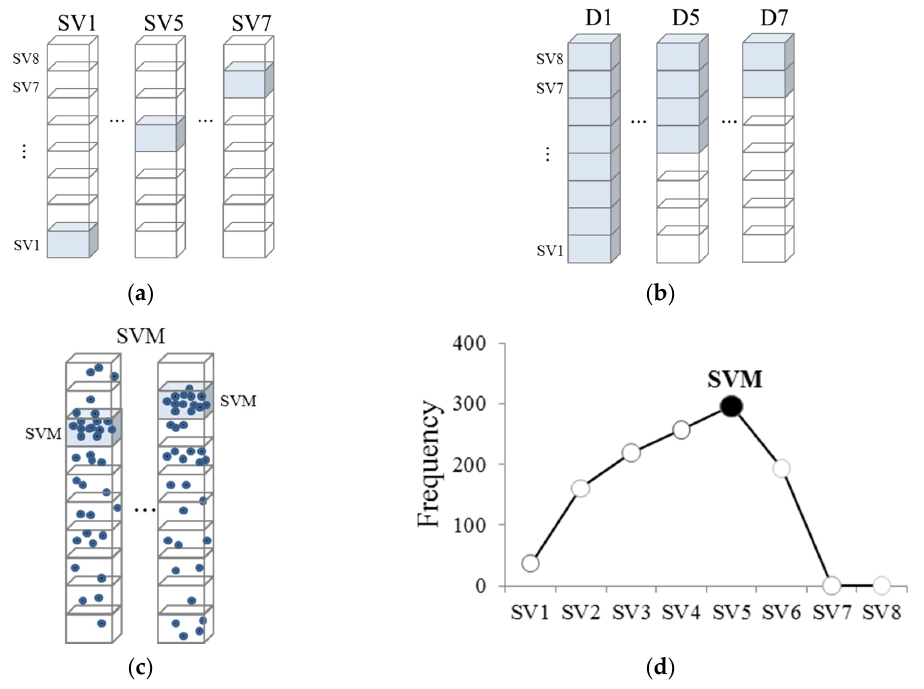
Figure 4. Illustration of the concepts of ( a ) Variable SVi; ( b ) Variable Di; ( c ) Variable SVM; and ( d ) finding the highest frequency among SVs under the Variable SVM.